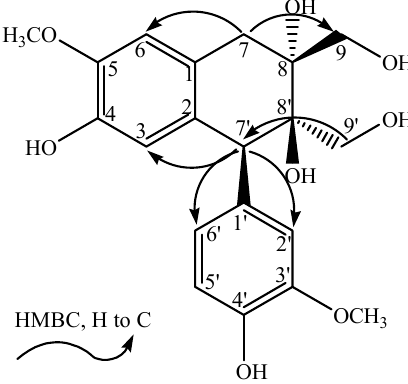
Figure 1. The key correlations of compound 1 .